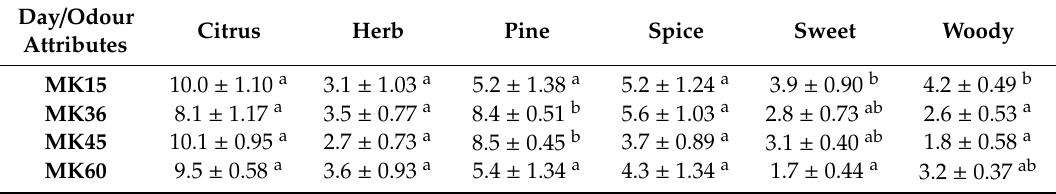
Table 4. Odour attributes from sensory analysis of makhwaen fruit essential